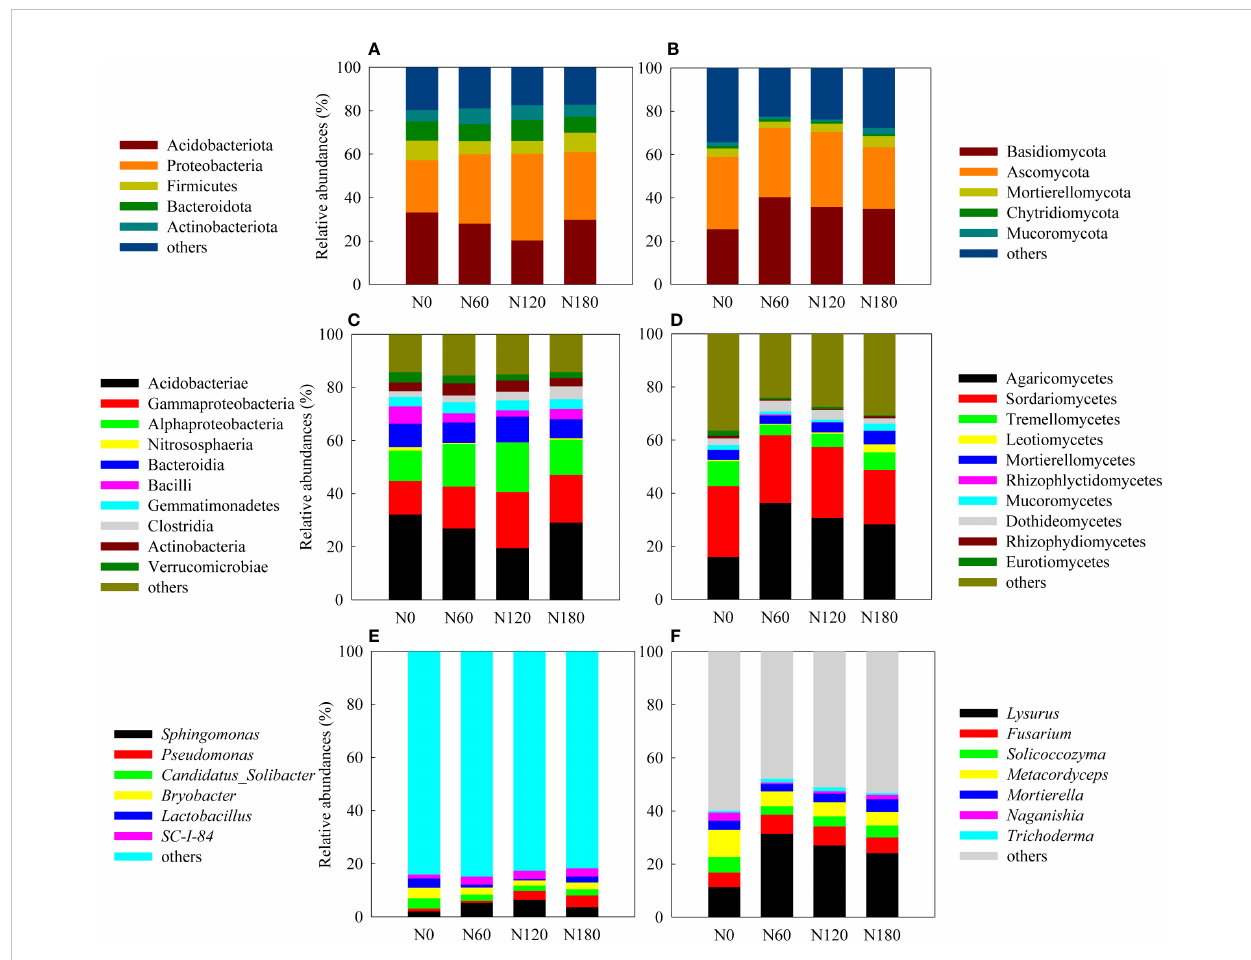
FIGURE 3 Relative abundances of the dominant bacterial and fungal OTUs at the phylum (A, B) , class (C, D) and genus (E, F) levels.